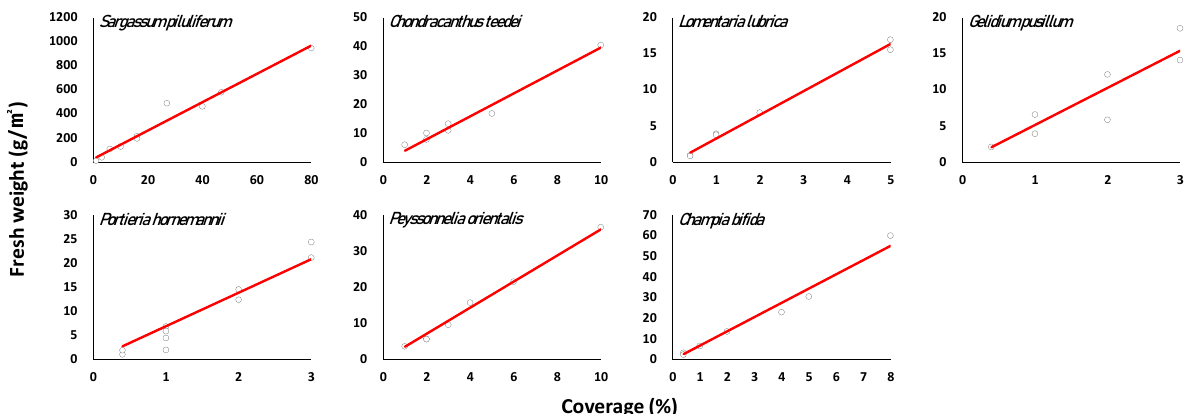
Figure 3. The regression line between marine macroalgal coverage and fresh weight of each species. The linear regression is the red line and power regression is the blue line.